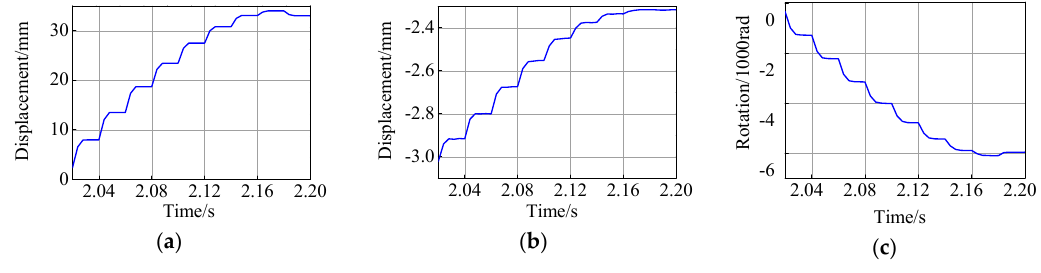
Figure 13. Displacement response in iteration (220 Gal), ( a ) Horizontal displacement; ( b ) Vertical displacement; ( c ) Rotation.